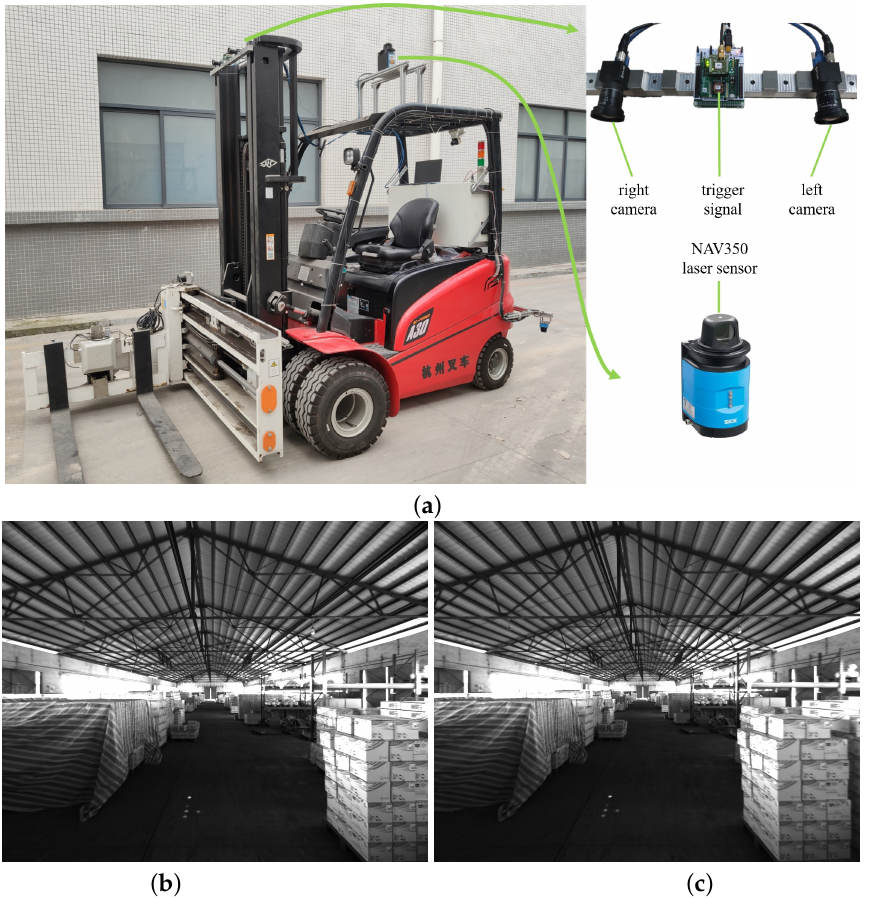
Figure 2. The forklift equipped with basic sensors in our proposed system. ( a ) Two monocular cameras triggered by the same signal source are used to capture pictures of the warehouse, and the NAV350 sensor is used to measure the global position of the forklift in the warehouse. ( b ) The image captured by left the monocular camera; ( c ) the image captured by the right monocular